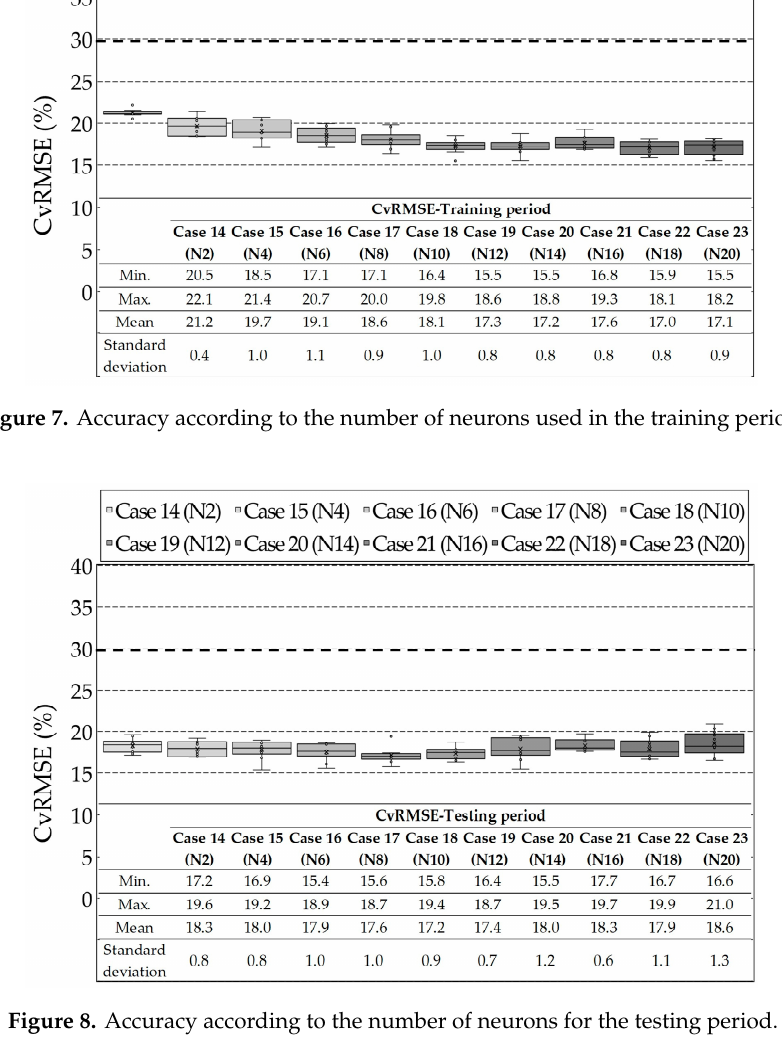
Figure 7. Accuracy according to the number of neurons used in the training period.